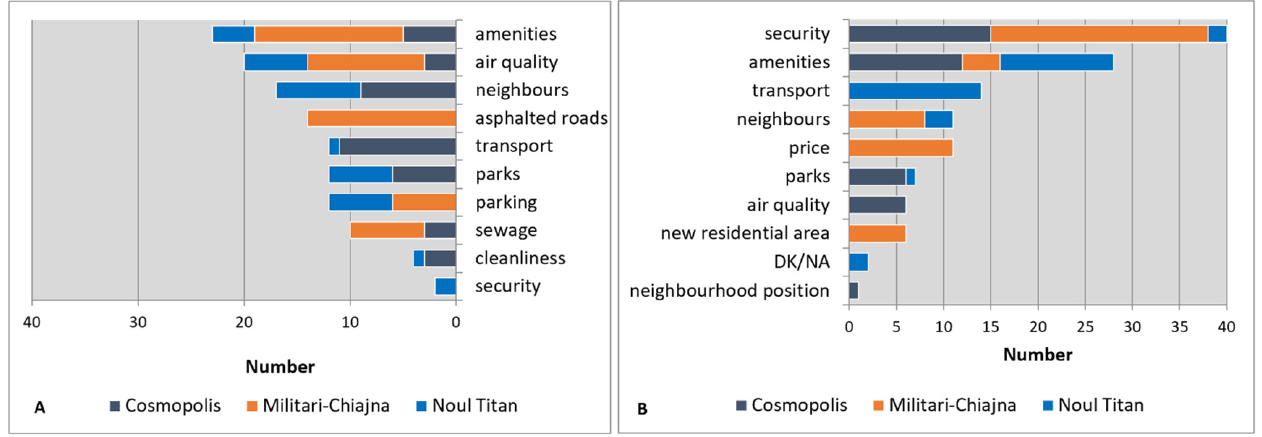
Figure 7. Negative ( A ) and positive aspects ( B ) of the new residential nuclei as per residents’ opin- ions.